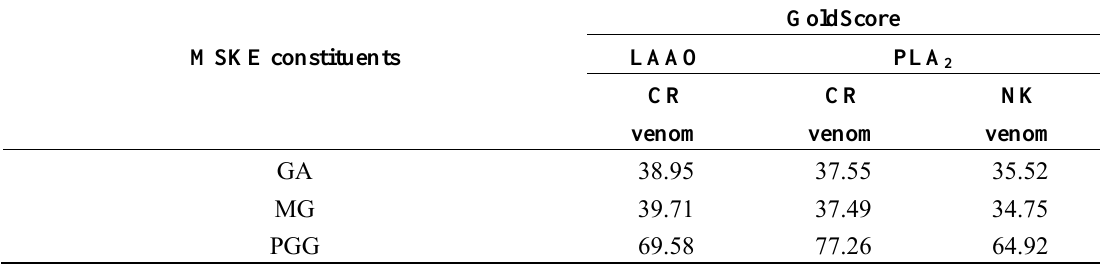
-CR and PLA -NK 2 2